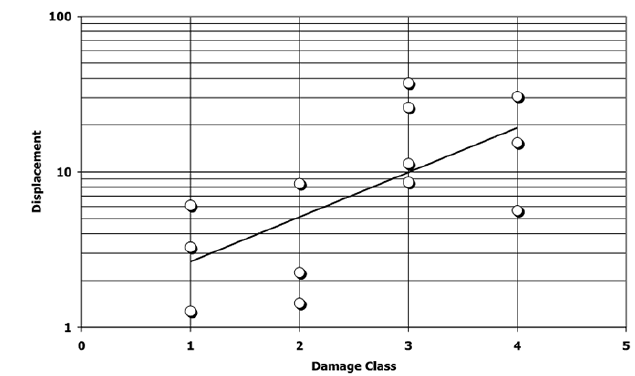
Figure 1. Damaged and calculated inter-storey displacement index correlation by Mucciarelli et al.